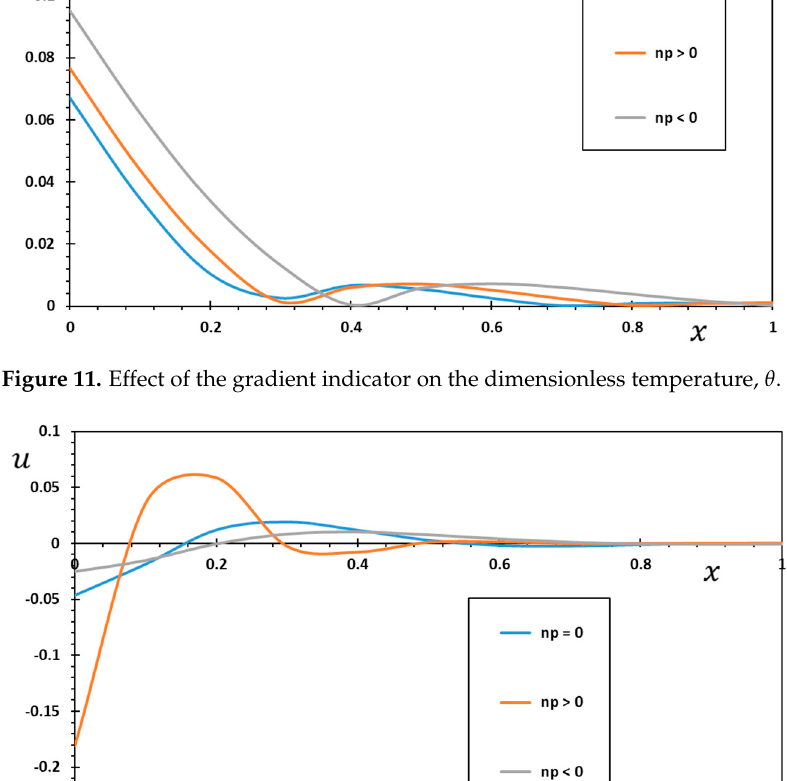
Figure 12. Effect of the gradient indicator on the dimensionless displacement, 𝑢 .